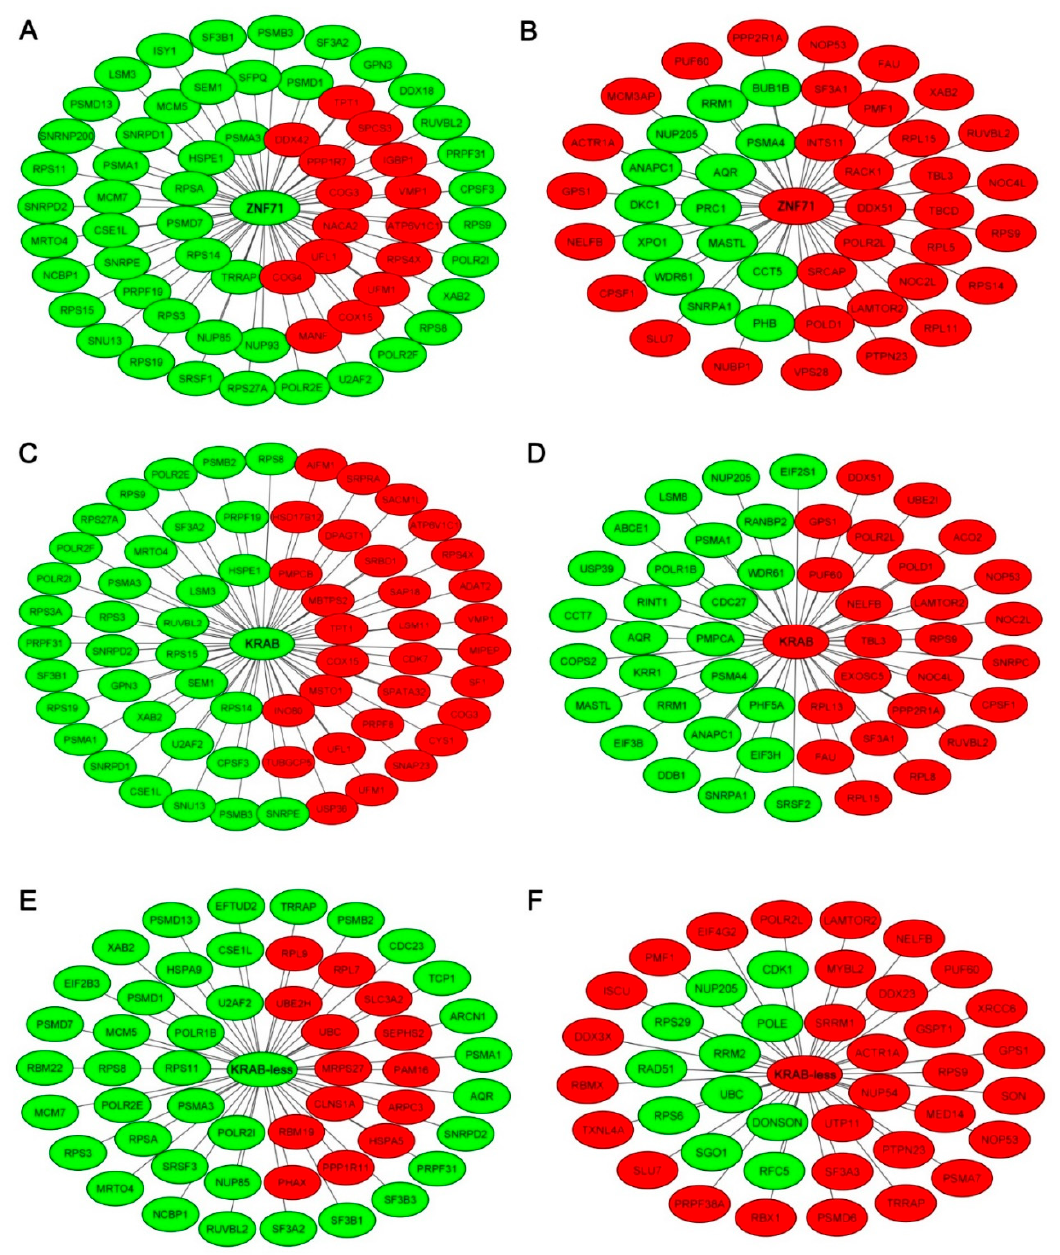
Figure 5. ZNF71 gene level, ZNF71 KRAB, and ZNF71 KRAB-less co-expression networks in patient cohort GSE81089. The green color indicates up-regulation or non-downregulation, and the red color indicates downregulation or non-upregula- tion. All proliferation genes in the networks were identified from CRISPR-Cas9/RNAi screening data in CCLE NSCLC cell lines, with more details provided in Supplementary File S3. ( A ) Proliferation genes that had a significant ( p < 0.05, z -tests) co-expression with up-regulated ZNF71 . ( B ) Proliferation genes that had a significant ( p < 0.05, z -tests) co-expression with down-regulated ZNF71 . ( C ) Proliferation genes that had a significant (p < 0.05, z-tests) co-expression with up-regulated ZNF71 KRAB isoform. ( D ) Proliferation genes that had a significant ( p < 0.05, z- tests) co-expression with down-regulated ZNF71 KRAB isoform. ( E ) Proliferation genes that had a significant ( p < 0.05, z -tests) co-expression with up-regulated ZNF71 KRAB-less isoform. ( F ) Proliferation genes that had a significant ( p < 0.05, z -tests) co-expression with down-regu- lated ZNF71 KRAB-less isoform. Details provided in Supplementary File S3.